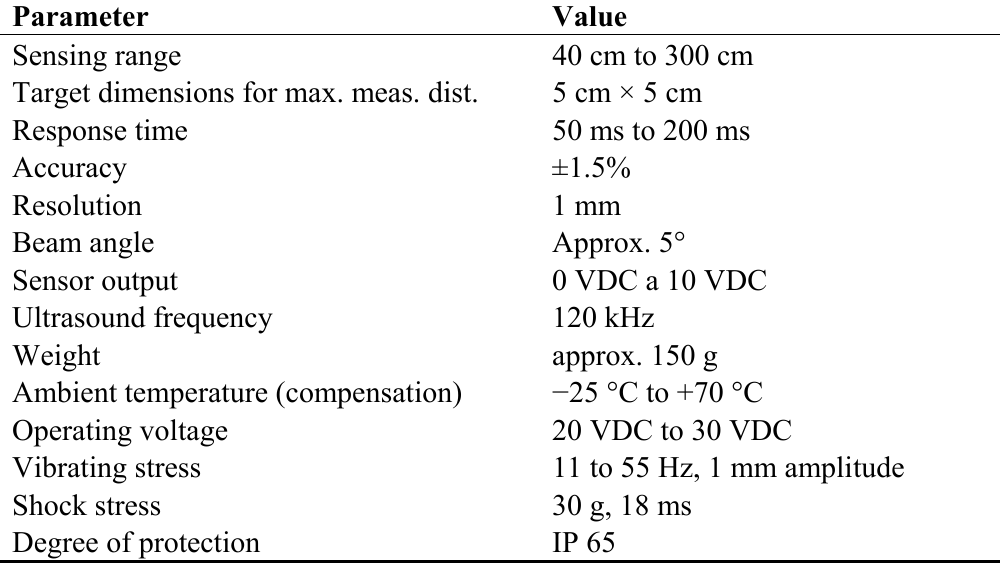
Table 1. Specifications of the ultrasonic sensor used in this work (model Sonar Bero PXS400 M30 K3, Siemens AG, Munich,